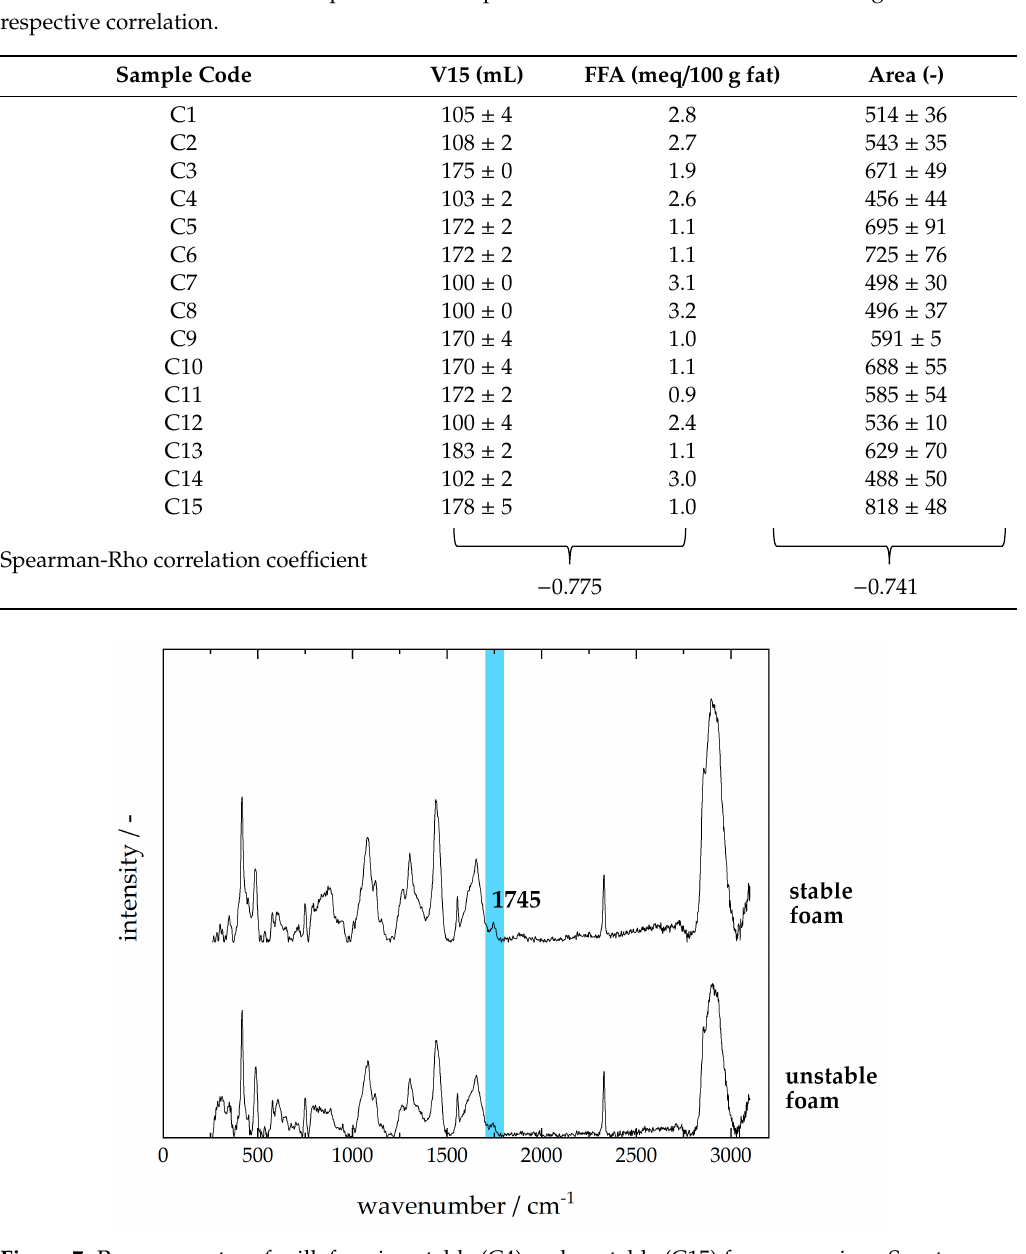
Table 2. Free fatty acid content of investigated ultrahigh temperature (UHT) milk samples (3.5% fat) and mean values for the total volume after 15 min (V 15 ) and the determined area under band 1745 cm − 1 in order of their consecutive sample code. The Spearman-Rho correlation coe ffi cient is given for the